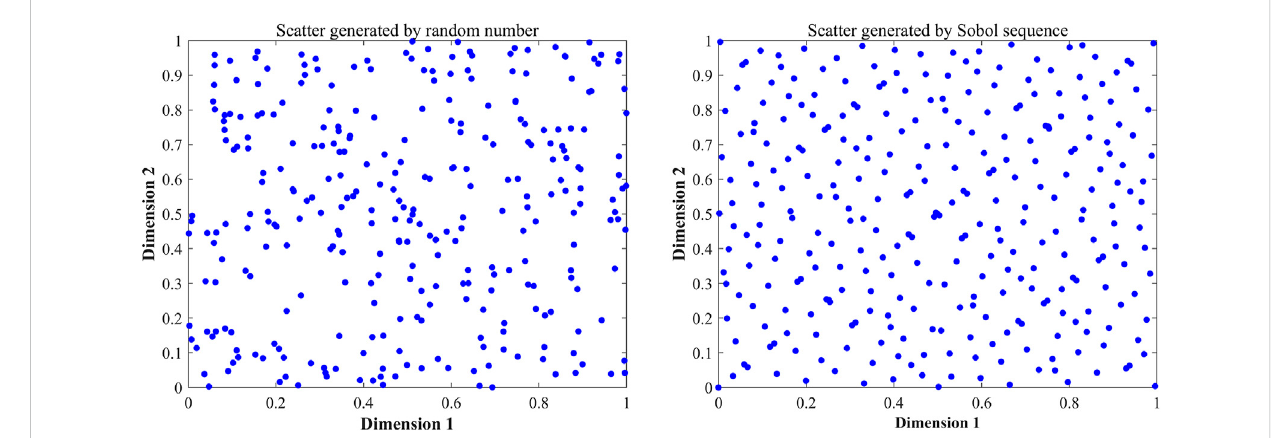
FIGURE 3 Spatial distribution of random numbers with Sobol sequences generating random